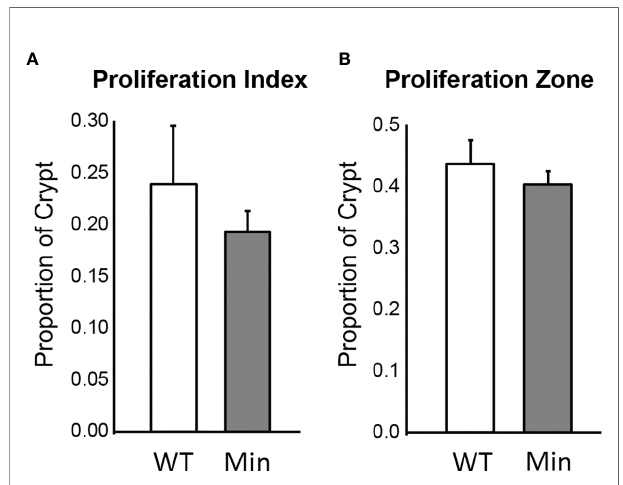
FIGURE 3 | Epithelial cell proliferation is similar in the distal colon of Apc +/Min-FCCC ( ‘ Min ’ ; n=12) vs . Apc +/+-FCCC wild type ( ‘ WT ’ ; n=4) mice. Bars represent mean ± S.E.M. (A) Fold change in mean proliferative index = 0.8; Welch ’ s t-test p = 0.55. (B) Fold change in mean size of the proliferative zone = 0.9; Welch ’ s t-test p = 0.56.